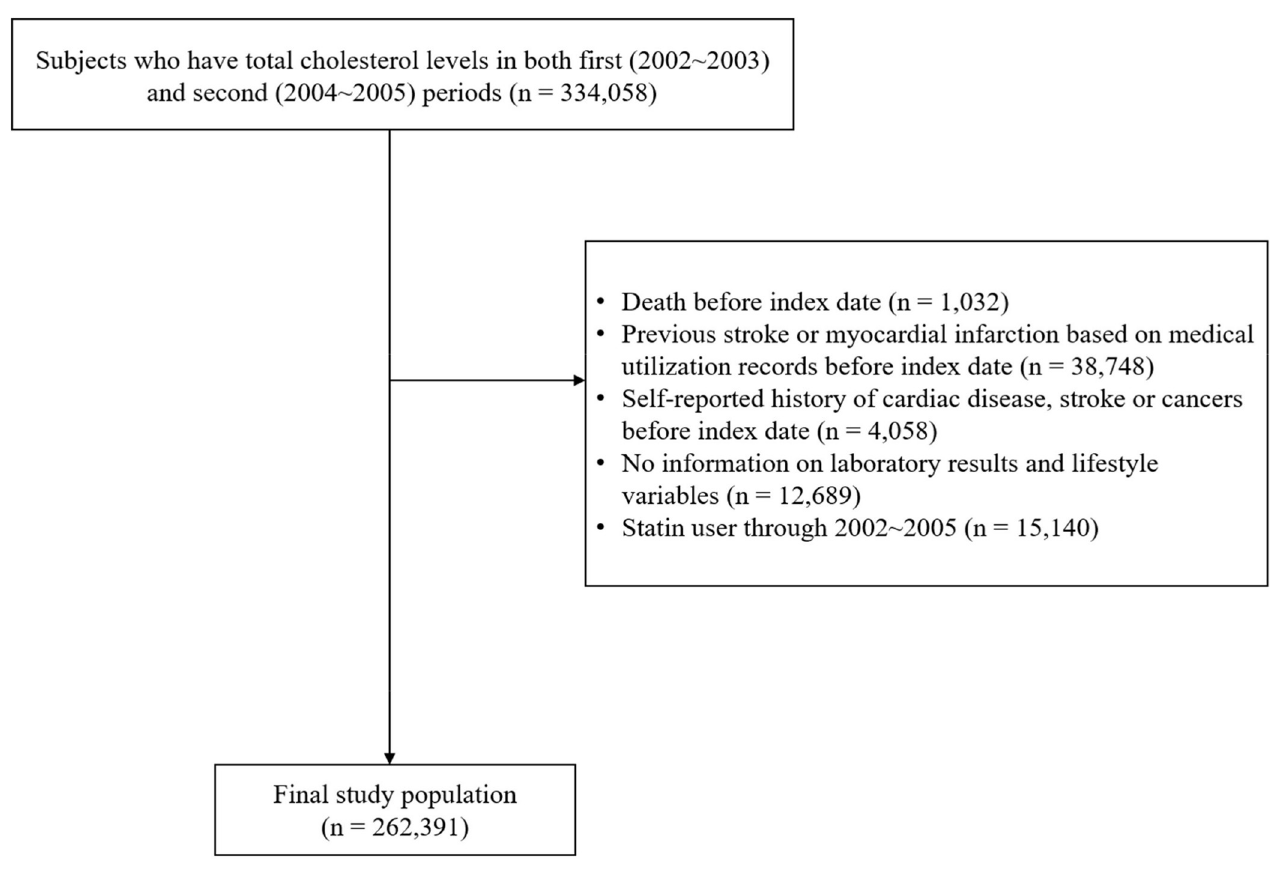
Fig 1. Flow chart of the study population